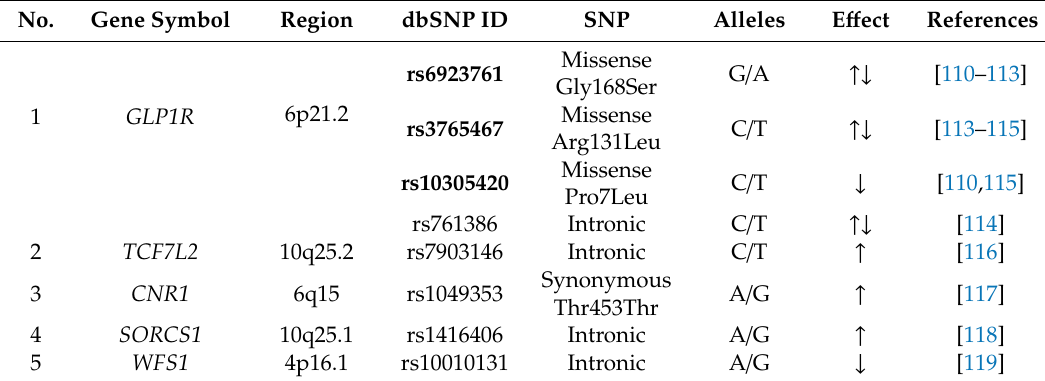
Table 3. Genetic variants that influence GLP1RA therapy